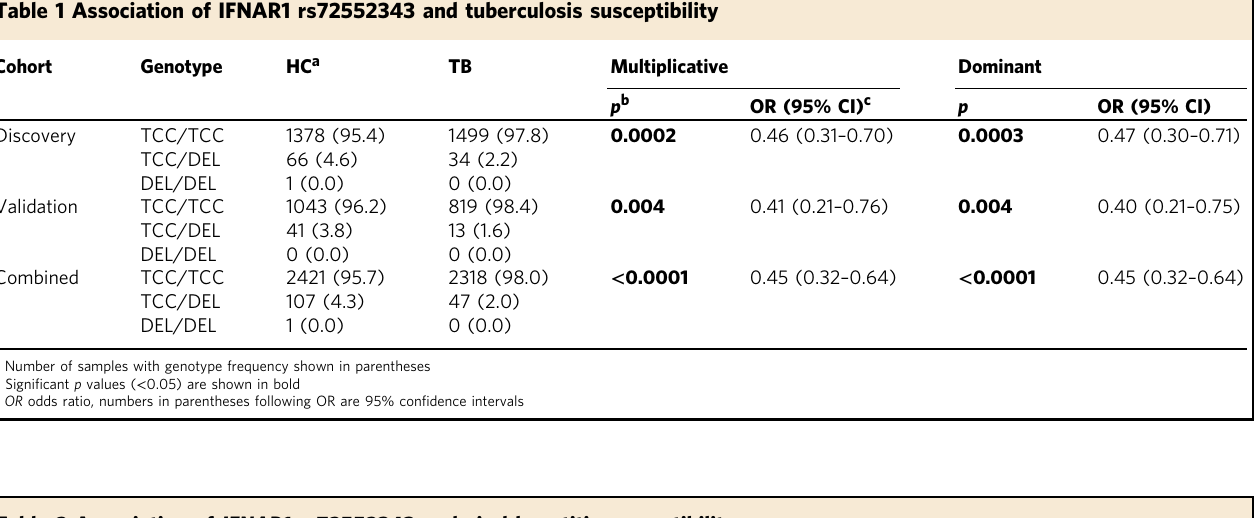
Table 2 Association of IFNAR1 rs72552343 and viral hepatitis susceptibility